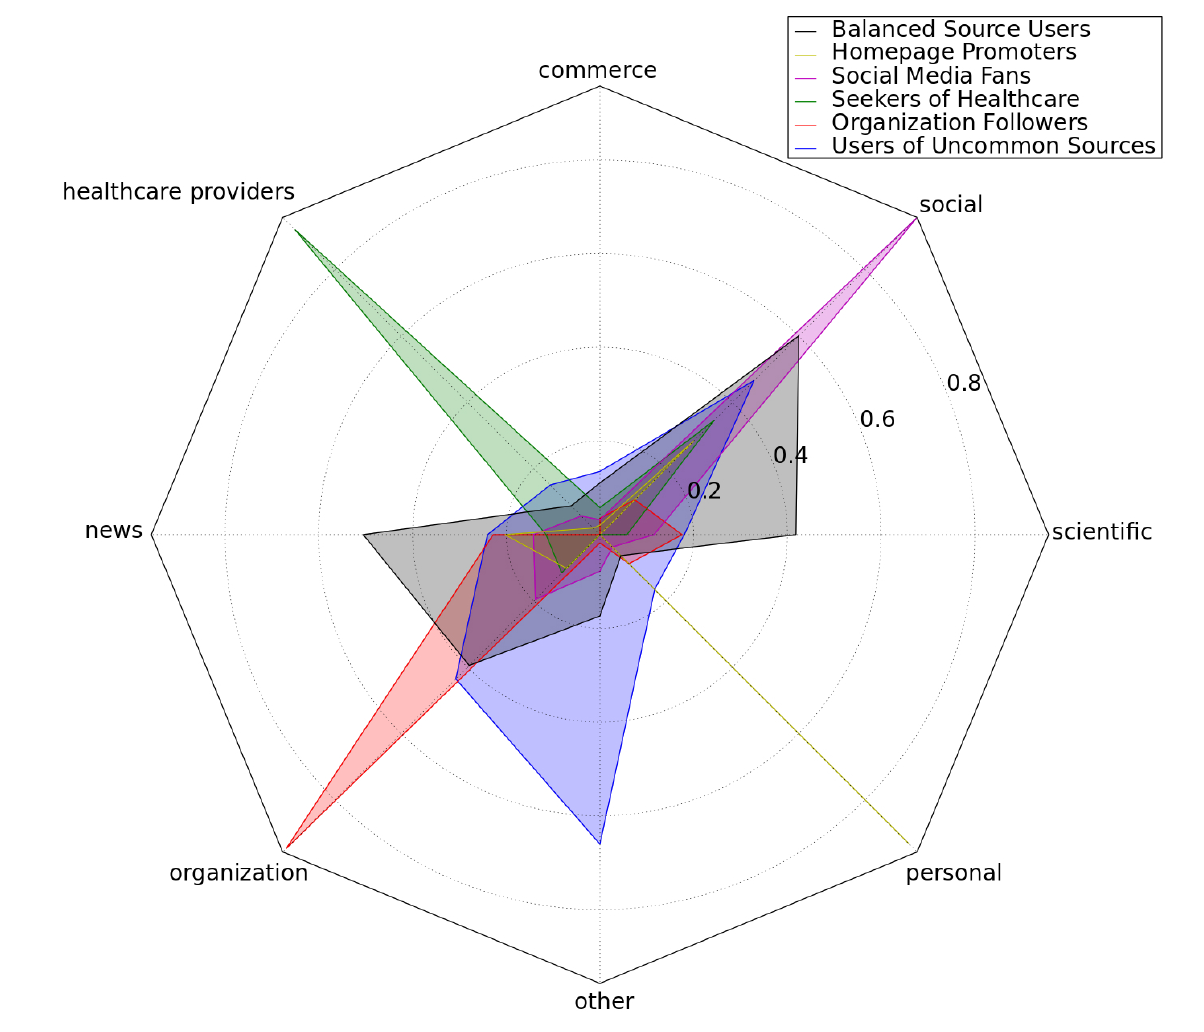
Figure 6. Radar chart showing aggregated domain class use of each cluster (the user vectors belonging to the cluster are summed up). Each cluster vector is a normalized to be a unit vector. The length of a spoke is proportional to the value it